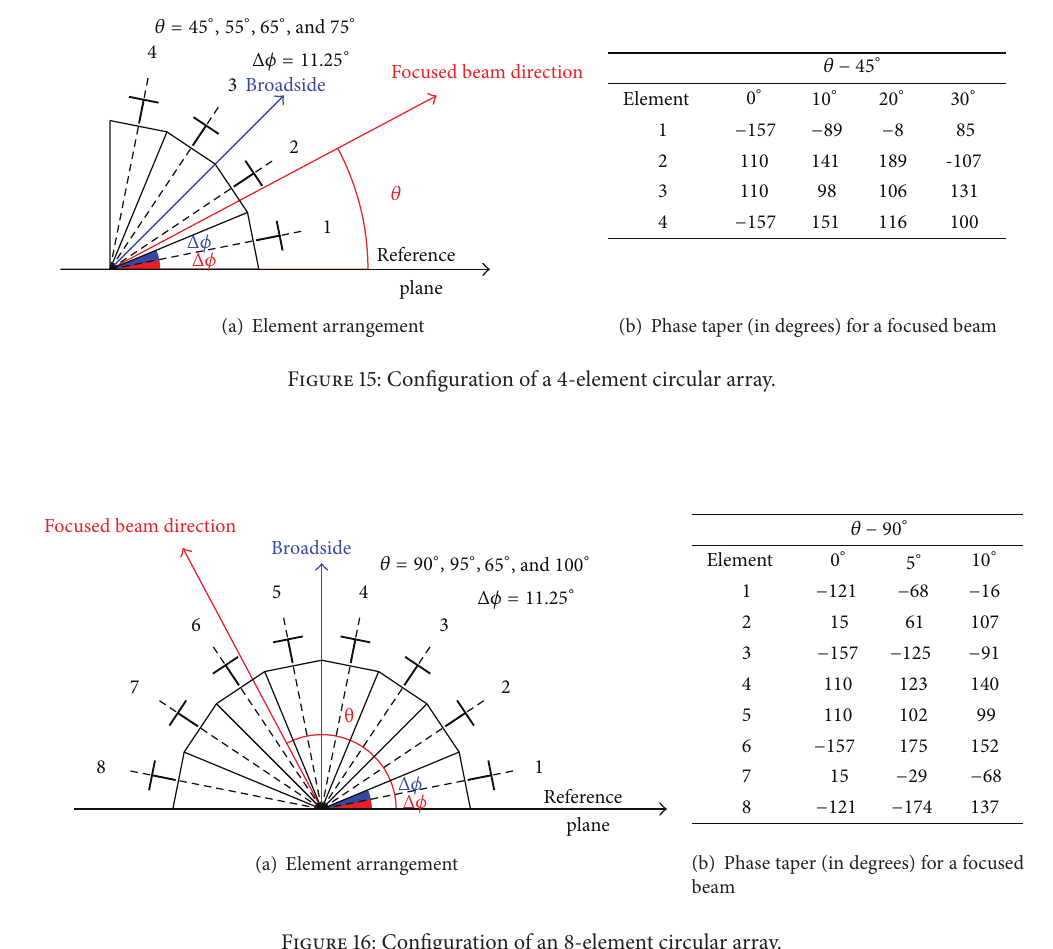
Figure 16: Configuration of an 8-element circular